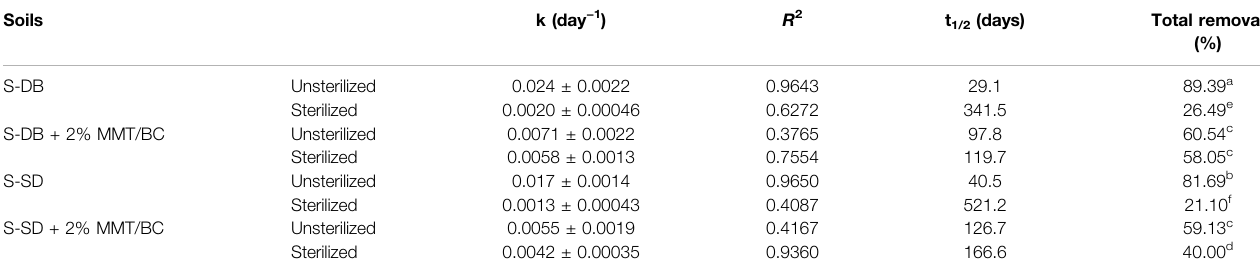
TABLE 4 | Degradation of atrazine in soils and biochar – soil mixtures during 120 days of incubation.